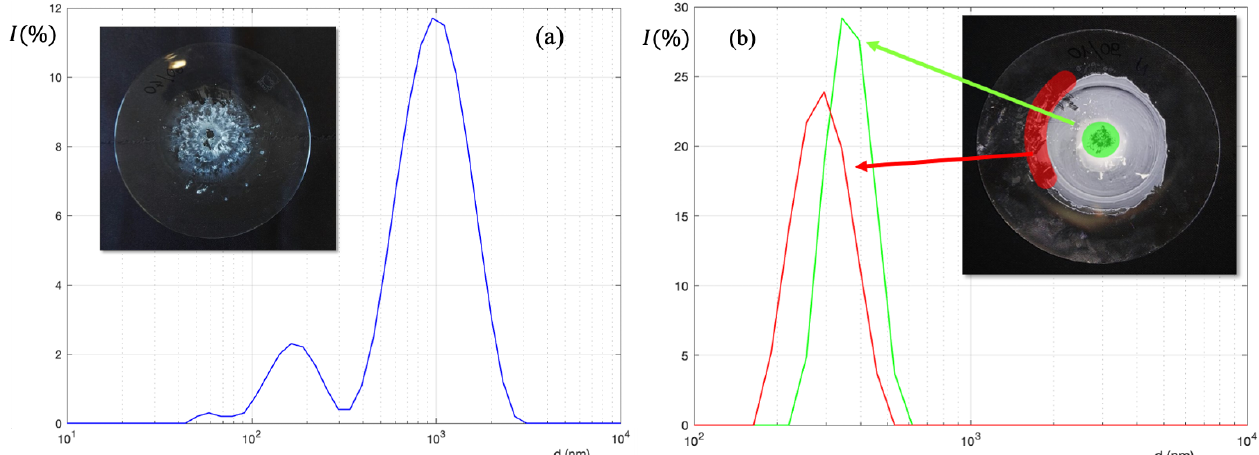
Figure 4. ( a ) Material obtained by rehydration of the formulation R = 1.5. The droplet size distribution of the rehydrated sample shows a large polydispersity indicating an inhomogeneity of the dispersion. The inset shows that the material is not spreadable on a glass slide. ( b ) Material obtained by rehydration of the formulation R = 9. The droplet size distribution of the rehydrated sample shows a low polydispersity, indicating a good homogeneity of the dispersion. The inset shows that the material is waxy and spreadable on a glass slide, material samples taken from two different points on the slide, after rehydration, exhibit similar droplet size